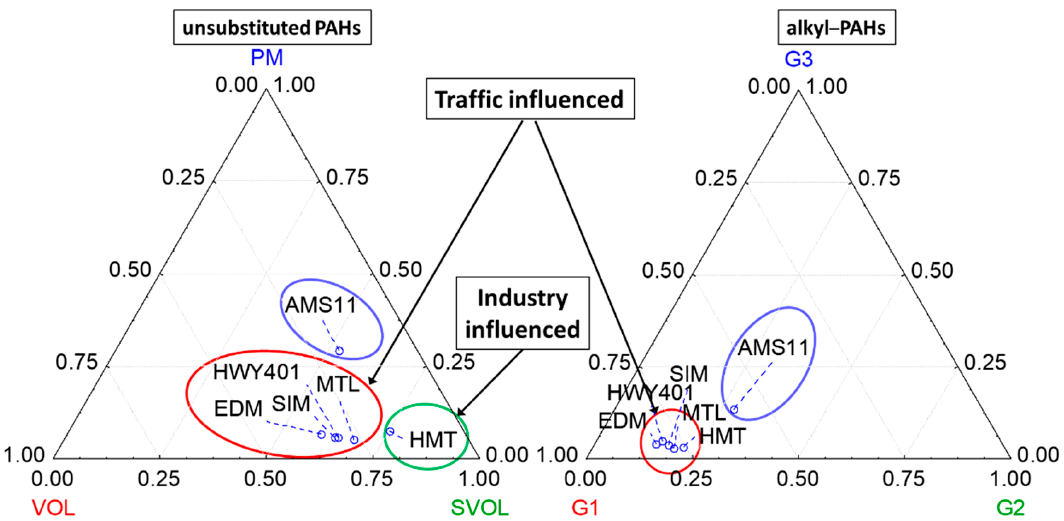
Figure 6. Unsubstituted PAH and alkylated PAH grouping clusters at the five NAPS sites and the industrial-petrogenic AMS11 site [16]. Circled grouped sites indicate similar relationship of volatility groupings amongst the sites (see Table S2 for grouping